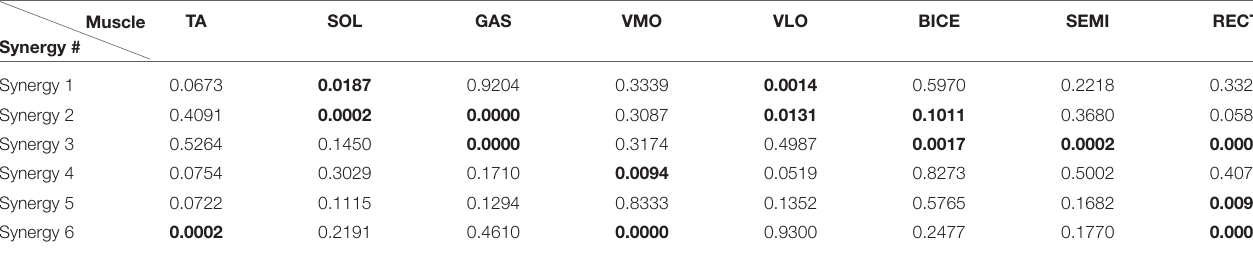
TABLE 3 | The p -values between muscle synergy W with ∈ R 6 × 8 and W without ∈ R 6 × 8 , p ≤ 0.05 indicates significant difference in statistics. Muscle TA SOL BICE Synergy #